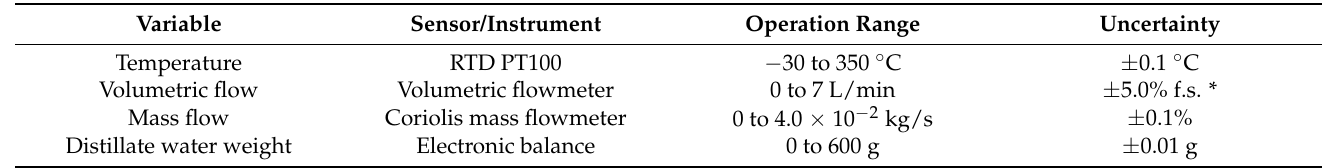
Table 2. Uncertainty of the measured variables.